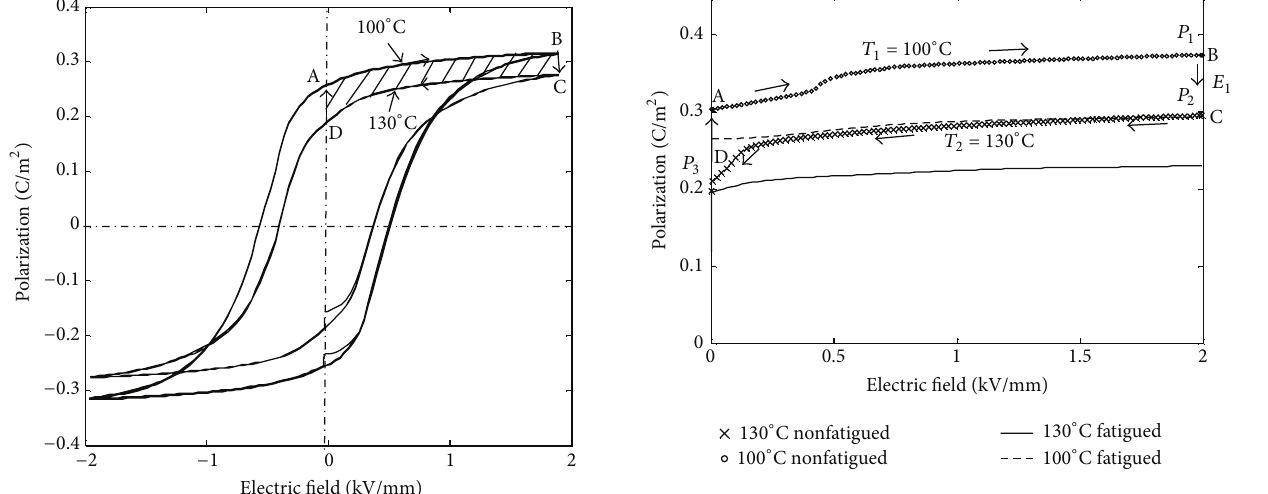
Figure 3: Normalized unipolar polarization Ericsson cycle for 2 samples of PZT-4.5PT, fatigued (after 600 cycles) and nonfatigued (after 30 cycles) between 100 and 130 ∘